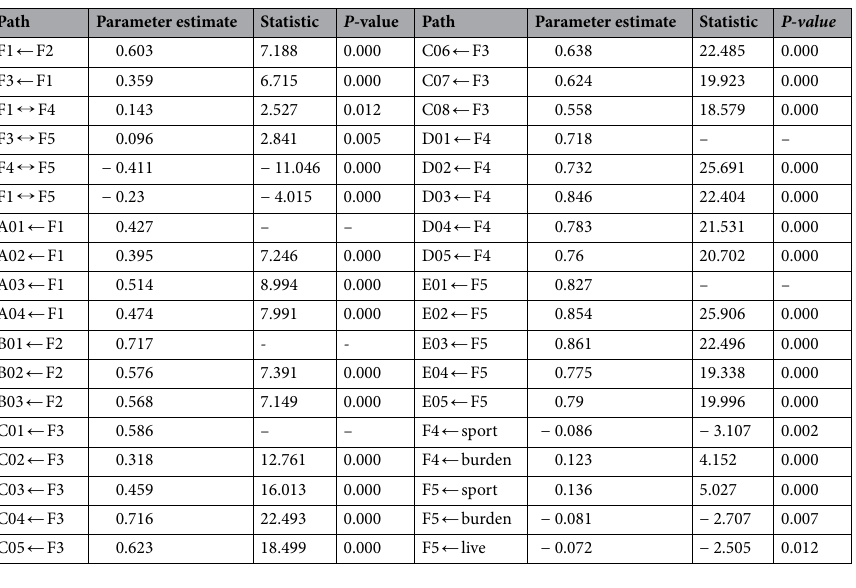
Table 6. Parameter estimates of the influencing factors of emotional disorders and happiness based on the structural equation model.